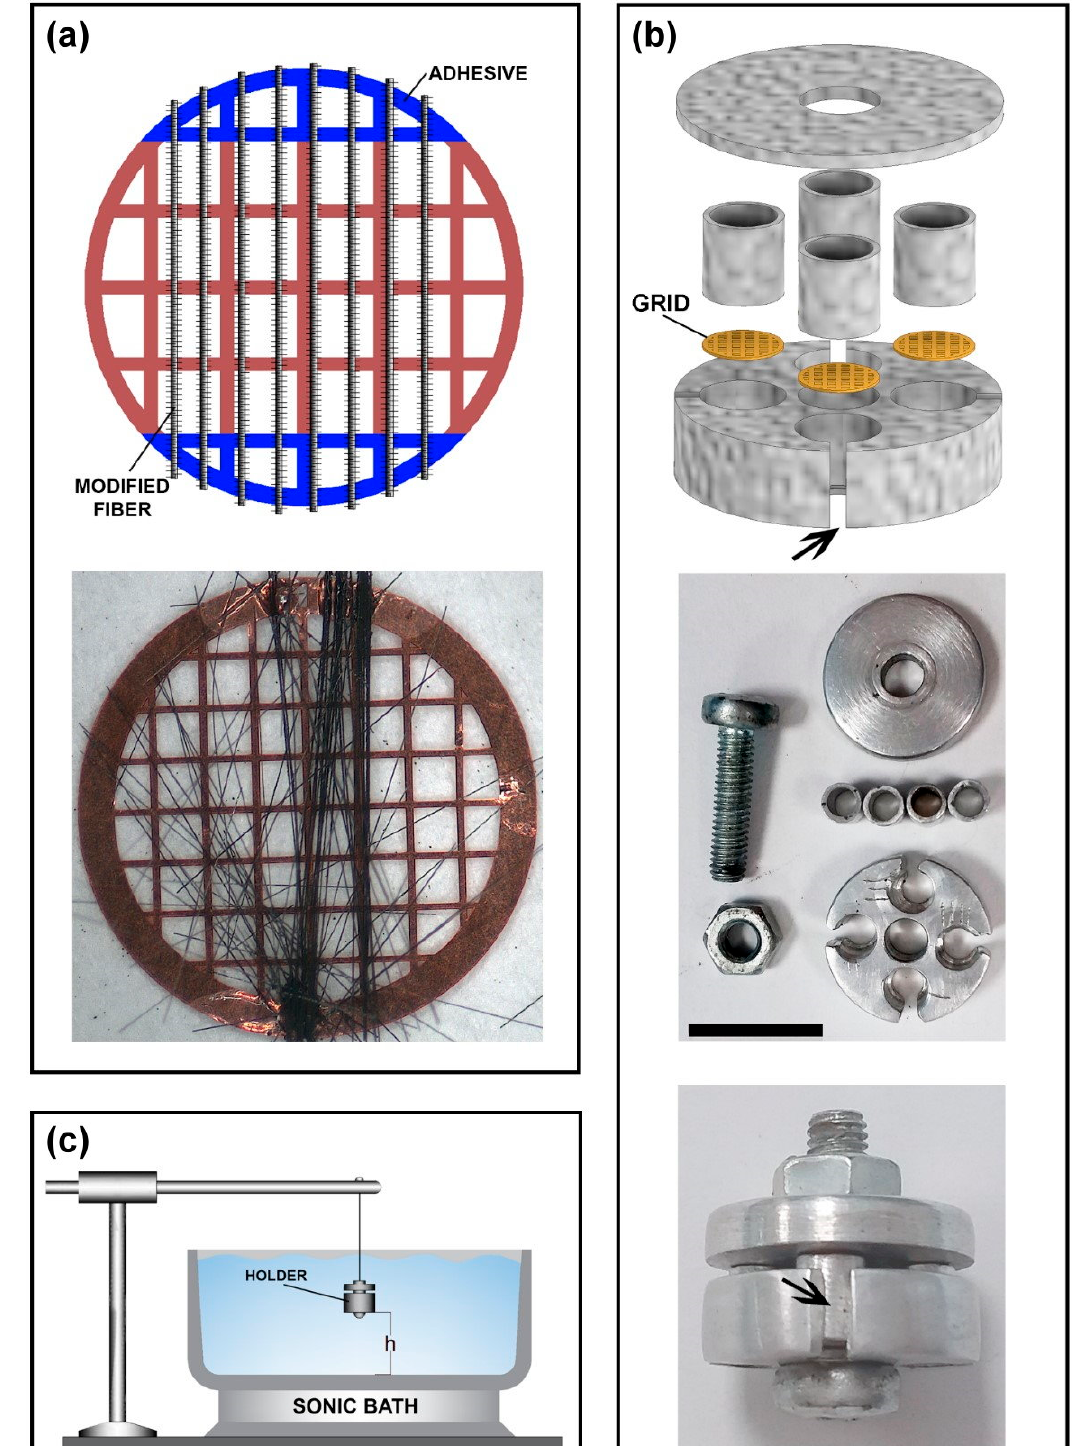
Figure 2. Schematic representation of the procedures used for the preparation and treatment of the hierarchical samples: ( a ) attachment of the microfibers to a TEM grid; ( b ) assembling a holder for simultaneous treatment of four TEM grids (every slot has a notch to remove the grid using sharp tweezers (marked with the arrows), scale bar 10 mm); ( c ) sonication treatment of the holder (the distance from the bottom (h) can be varied to adjust the intensity of the treatment).